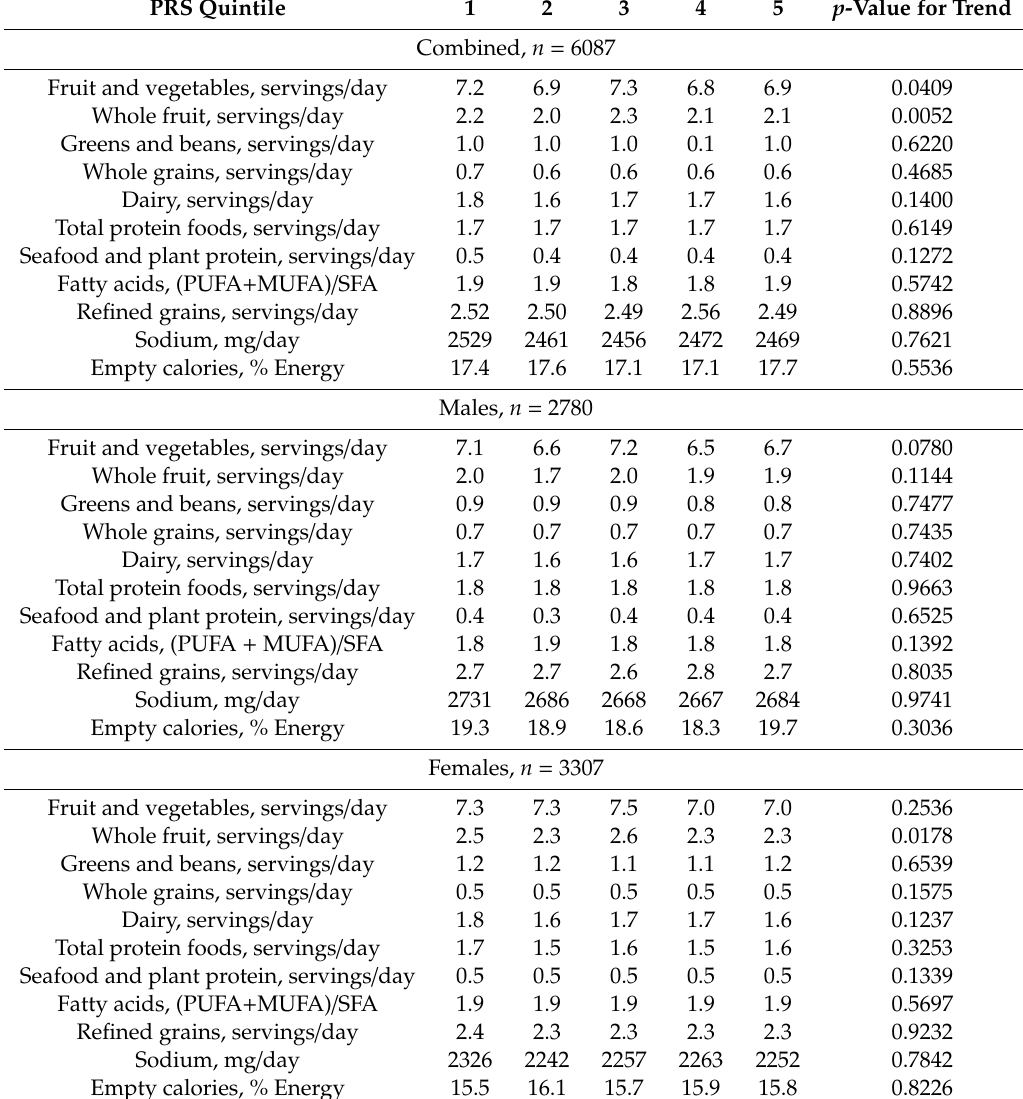
Table 4. Mean of HEI-C individual components by PRS quintile among diet sample. PRS